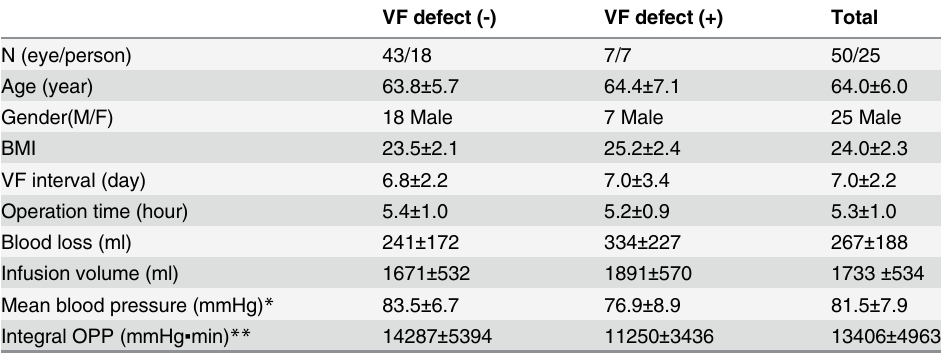
VF defect: Visual fi eld defect after robot-assisted laparoscopic radical